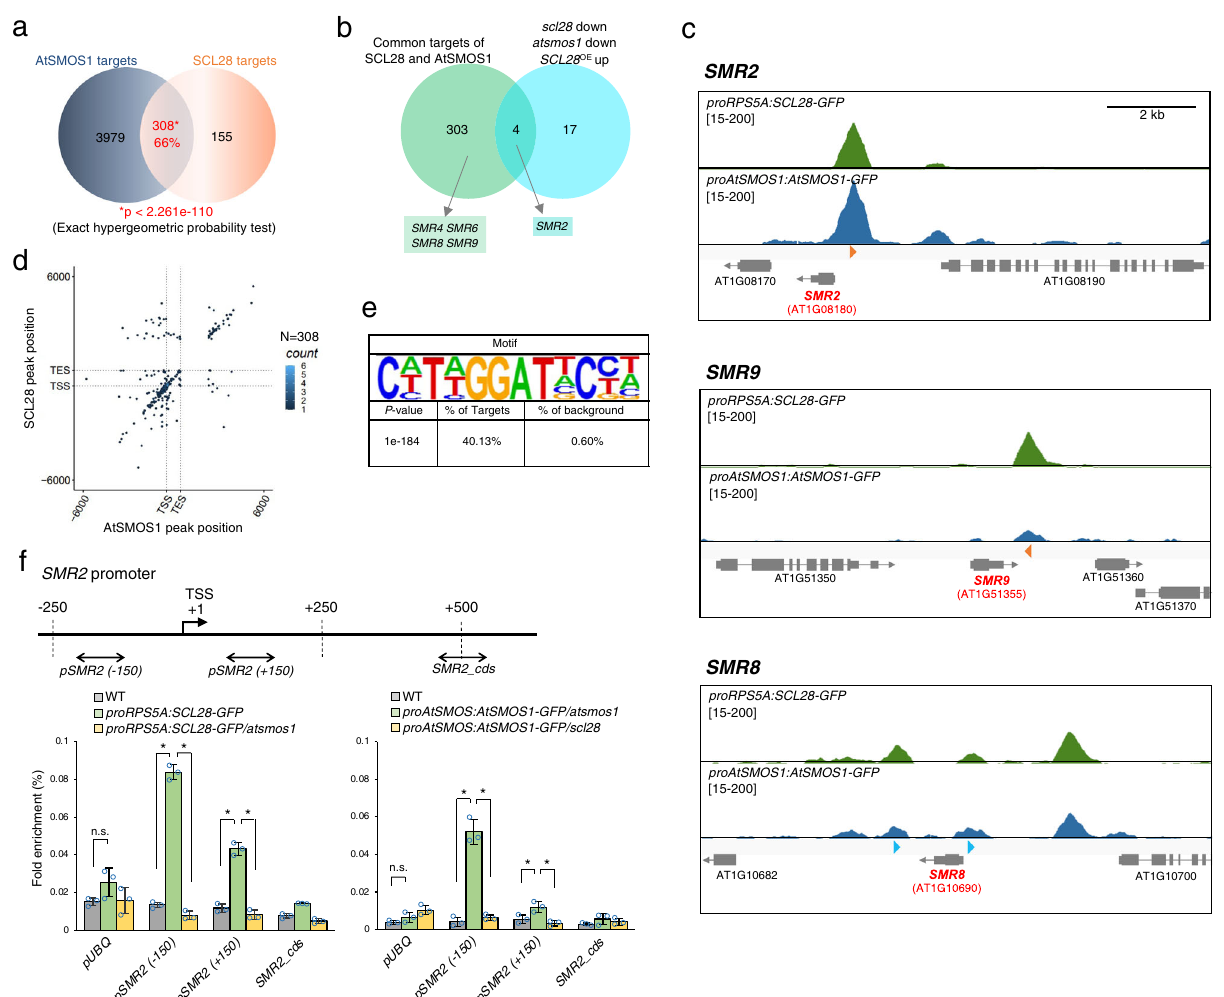
Fig. 6 Binding of active SCL28-AtSMOS1 heterodimer to target SMR genes. a Venn diagram showing signi fi cant overlap between genes bound by AtSMOS1 and SCL28. Signi fi cance of the overlap was evaluated using one-sided hypergeometric tests (no adjustment). b Venn diagram showing limited overlap between common target genes bound by SCL28 and AtSMOS1 and those downregulated in both scl28 and atsmos1 and upregulated in SCL28 OE . SMR genes found in overlapping and non-overlapping regions are also shown. c ChIP-Seq pro fi les for SCL28 and AtSMOS1 around SMR2 , SMR8 , and SMR9 loci. Orange arrowheads indicate DNA motifs perfectly matching C(a/t)T(a/t)GGATNC(c/t)(a/t), identi fi ed as an enriched motif in the SCL28/AtSMOS1 common targets, whereas blue arrowheads indicate motifs matching the enriched motif with one base mismatch (see Fig. 6e). d Density plot showing overlap of SCL28 and AtSMOS1 using hexagonal binning routine. Each dot represents the distance from the peak midpoint to the nearest gene. The y -axis shows location of the AtSMOS1 peak midpoint compared with gene position, while the x -axis indicates location of SCL28 peak midpoint compared with nearest gene. The large number of dots occurs along the positive correlation line, showing the co-occurrence pattern of SCL28 and AtSMOS1. e DNA motif overrepresented in common targets for SCL28 and AtSMOS1. HOMER motif search identi fi ed a speci fi c common SCL28/AtSMOS1 binding motif with a P value of 1e − 184 (one-sided hypergeometric tests, no adjustment), which was found in 40.13% of common targets. f ChIP-qPCR analysis was performed on SMR2 loci using plants carrying proRPS5A::SCL28-GFP under WT and atsmos1 backgrounds, and those carrying proAtSMOS1::AtSMOS1-GFP under scl28 and atsmos1 backgrounds. Ampli fi ed regions ( − 150, + 150, and cds) in ChIP-qPCR are shown by double-headed arrows. UBQ locus was analyzed in the same way as a negative control without binding. Data are shown as averages from three technical replicates (±SD). Statistical signi fi cance was determined using two-sided Student ’ s t test. * P < 0.05. n.s., not signi fi